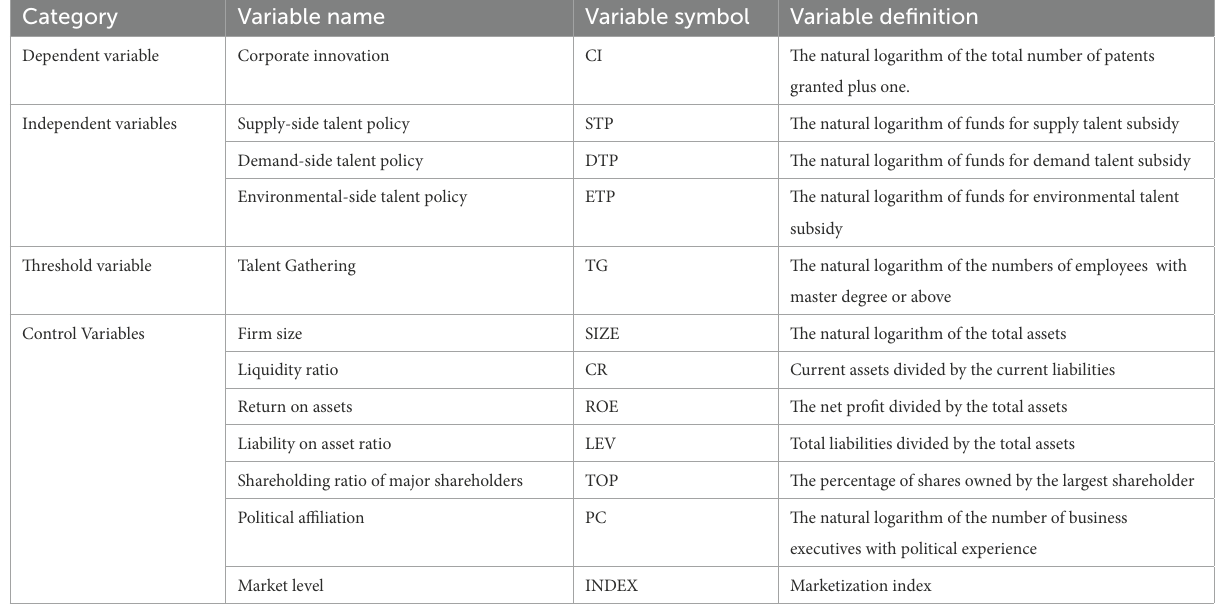
TABLE 2 Variable specification.